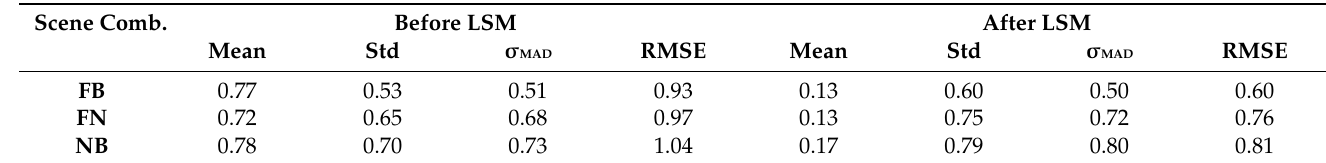
Table 5. Accuracy assessment (RPC refinement with 43 GCPs) of Pléiades DSMs in open areas (given values are in